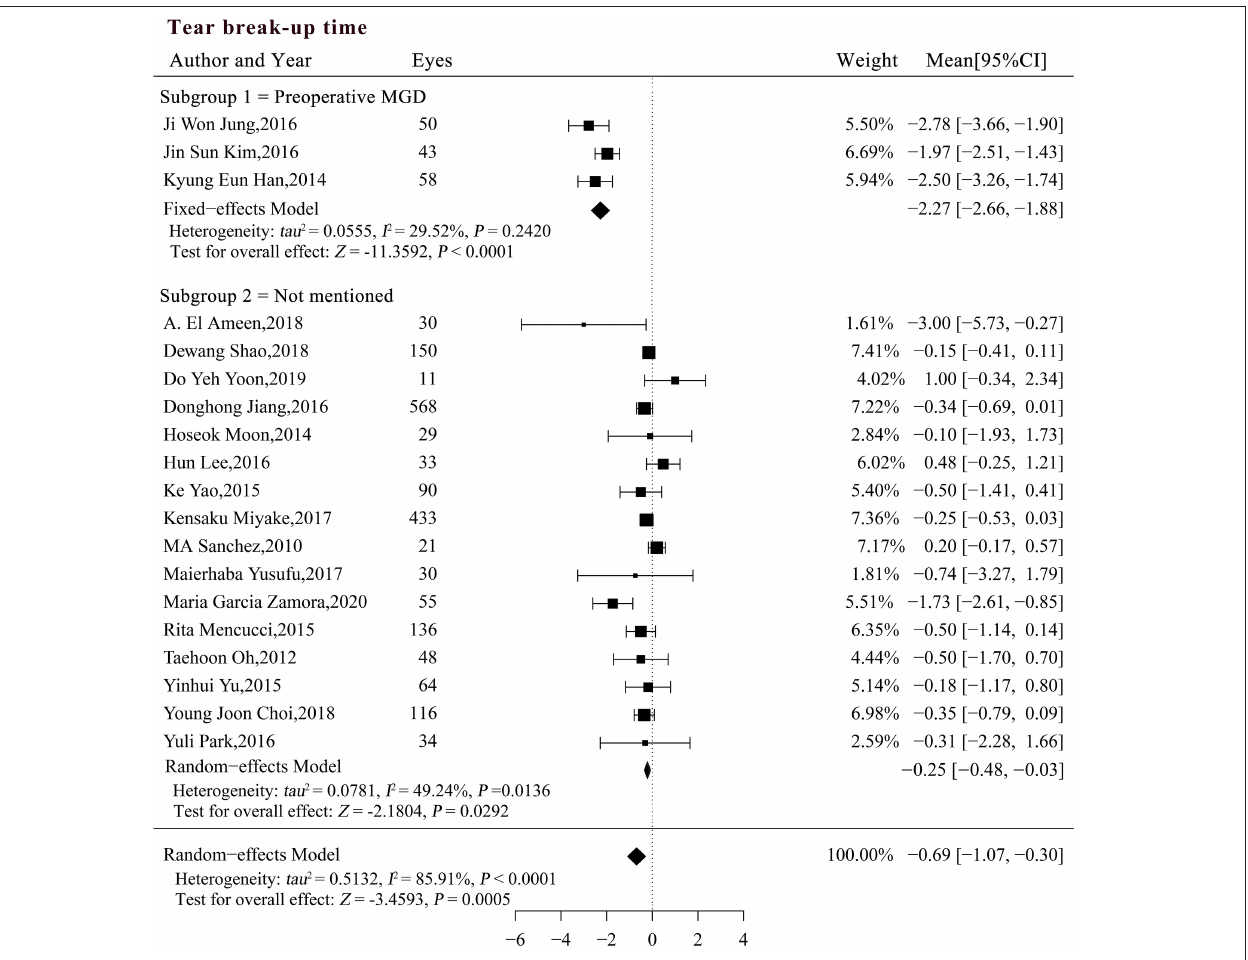
FIGURE 3 | Forest plots of change in tear break-up time after phacoemulsification cataract surgery. CI, confidence interval; MGD, meibomian gland dysfunction; DED, dry eye